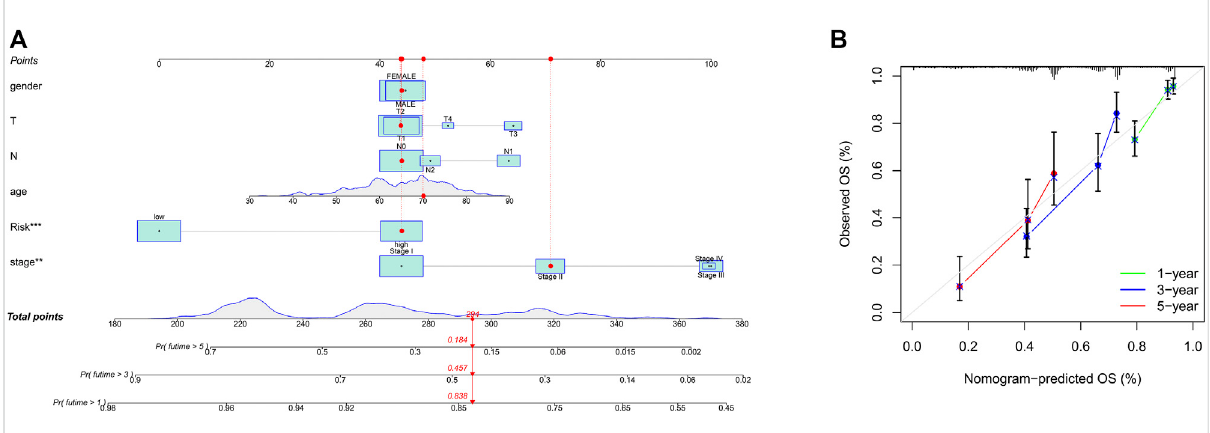
FIGURE 6 Prognosis prediction by the nomogram. (A) , A nomogram used to predict the overall survival. (B) , Calibration plots for